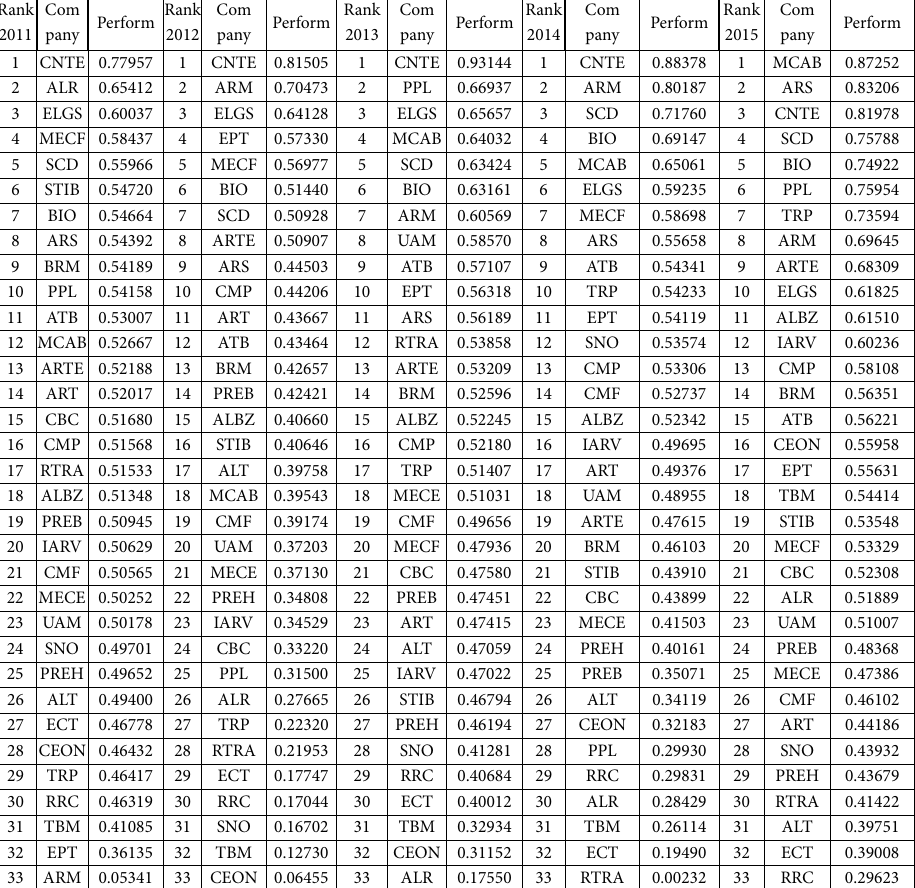
Table 10. Ranking of the companies in relation to all financial indicators (VFP and